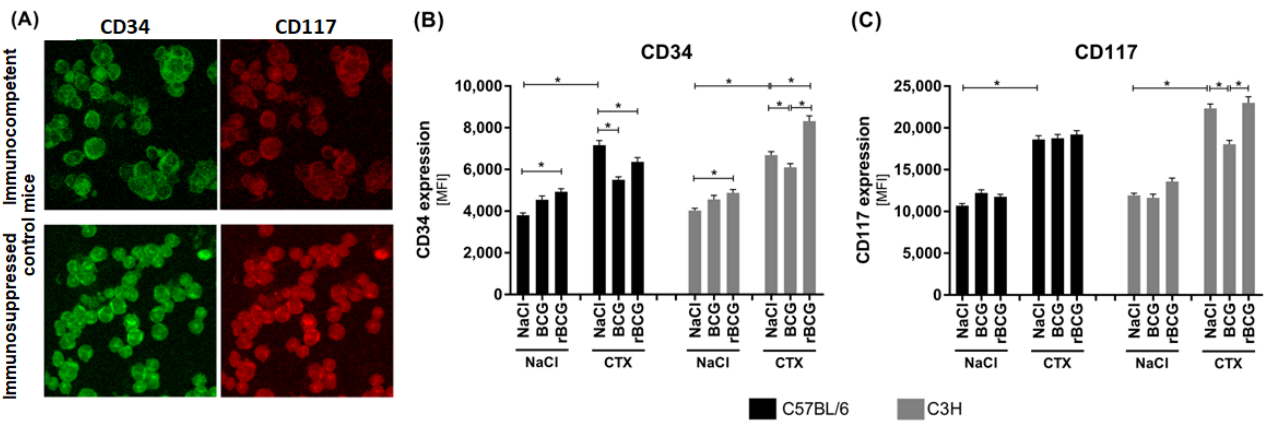
Figure 2. The expression of CD34 and CD117 on bone marrow cells in C57BL6 and C3H mice, in immunocompetent mice and in mice who were immunocompromised with cyclophosphamide (CTX), and in mice who were non-immunized or immunized with Mycobacterium bovis wild-type BCG or by the recombinant BCG (rBCG) strain secreting IL-18. ( A ) Representative confocal laser scanning microscopy images (NikonD-Eclipse C1 microscope equipped with an inverted 60× objective). Bone marrow cells were stained with DyLight 488-conjugated rat monoclonal anti-mouse CD34 ( B ) and with allophycocyanin (APC)-conjugated rat monoclonal anti-mouse CD117 ( C ). Data are shown as mean ± SEM (standard error of the mean). Asterisk (*) indicates p value ≤ 0.05; NaCl — physiological saline solution NaCl 0.9%; CD — cluster of differentiation; MFI — mean fluorescence intensity.